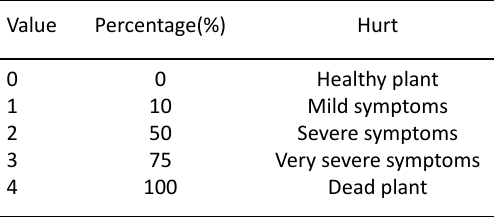
Table 2. Incidence scale of root rot in Manzano chili seedlings caused by P. capsici .